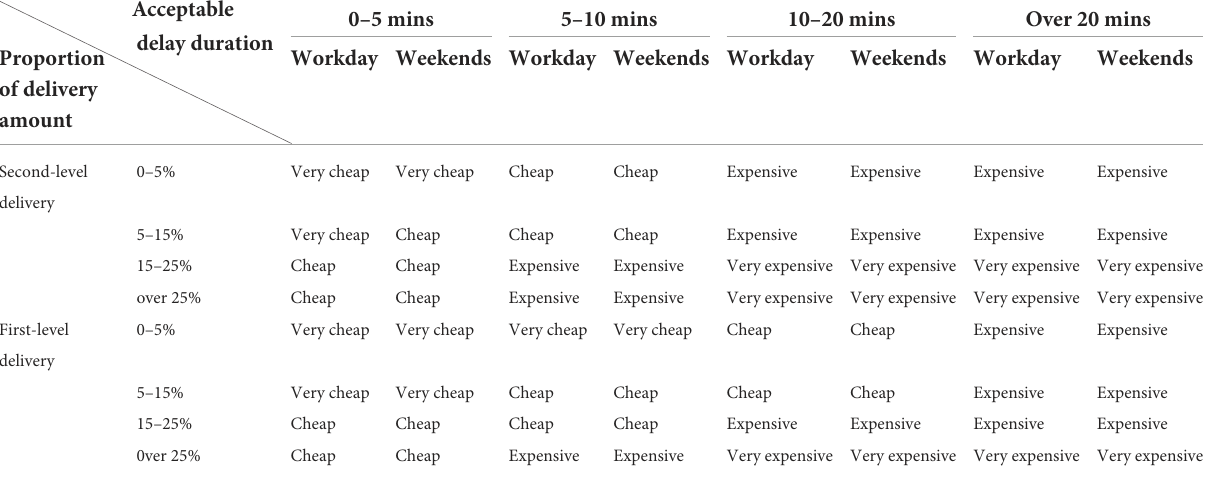
TABLE 5 Consumers’ s attitude toward the order cost under different